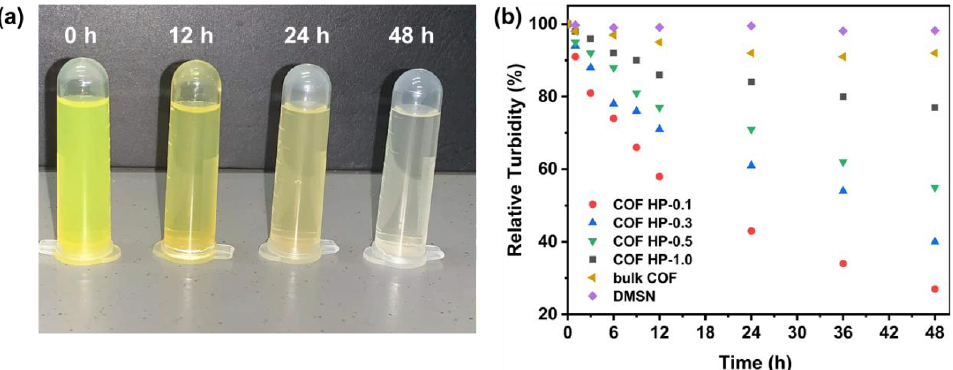
Figure 5. The optical photographs of the turbidity change of COF HP-0.1 in a pH 5.5 solution ( a ). The time-relative turbidity of bulk COF, DMSN, and COF HP of the various thicknesses in pH 5.5 solution ( b ).